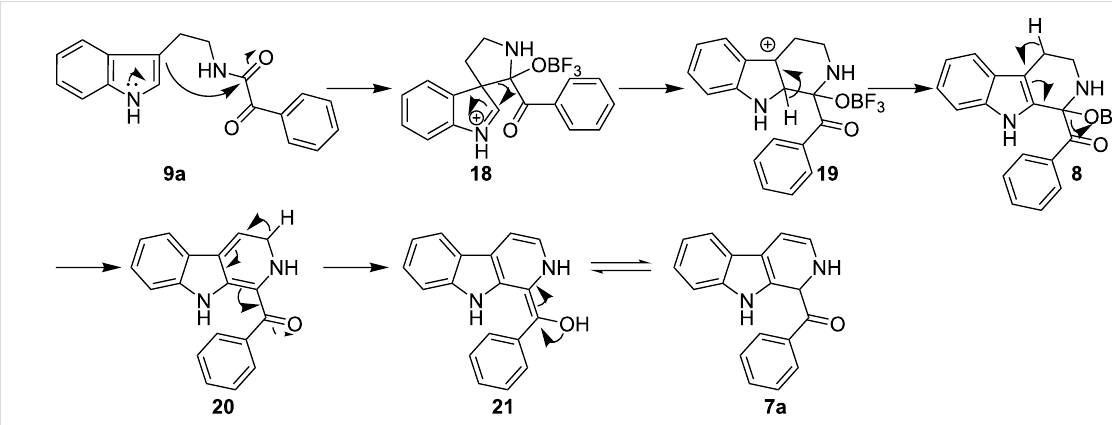
Scheme 5: Plausible mechanism for the formation of 7 .